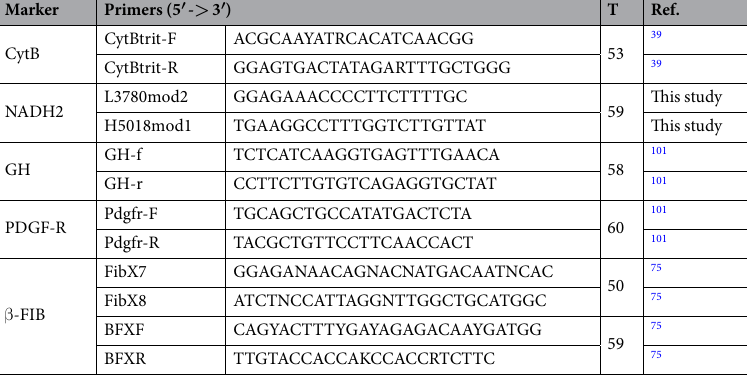
Table 2. Polymerase chain reaction primers and annealing temperatures (°C) used to amplify the two mitochondrial and three nuclear DNA fragments that were used in this